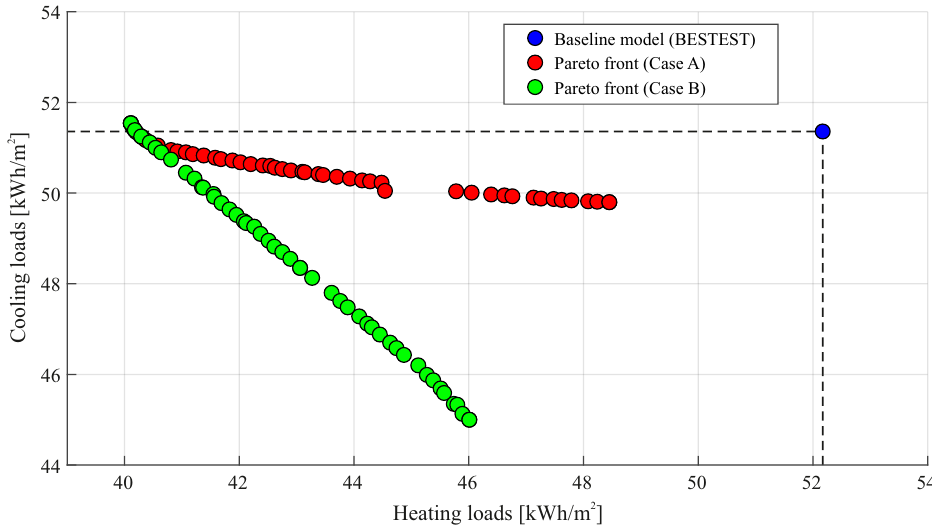
Figure 9. Comparison of the Pareto fronts for Case A and Case B.